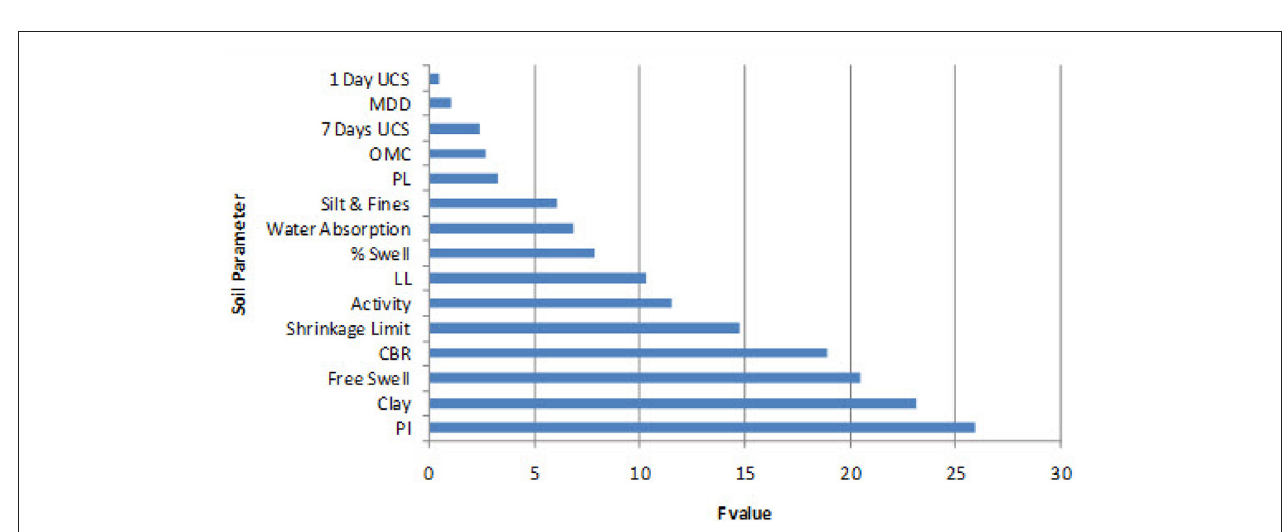
FIGURE 13 | Degree of effect of nanomaterial addition on active soil